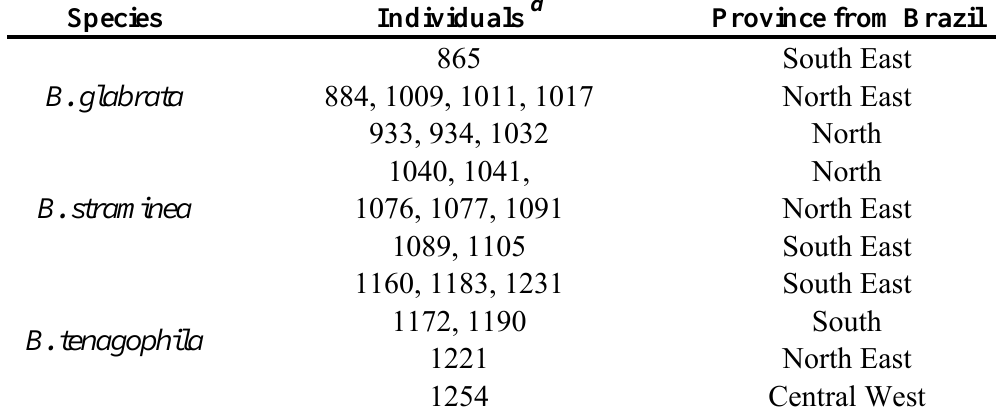
Table 1. Individuals from Biomphalaria genus distributed according to Brazilian